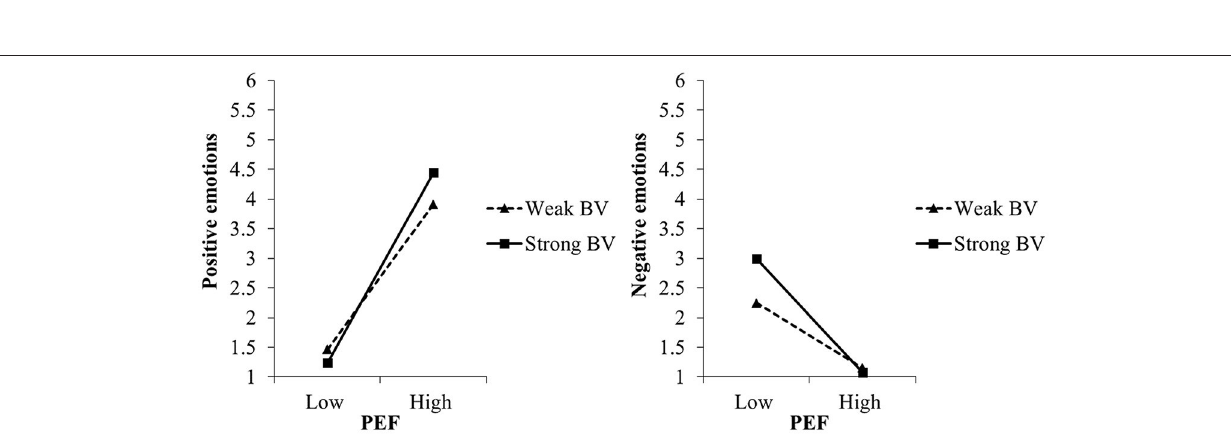
person at libraries and cafés of the University ( n =